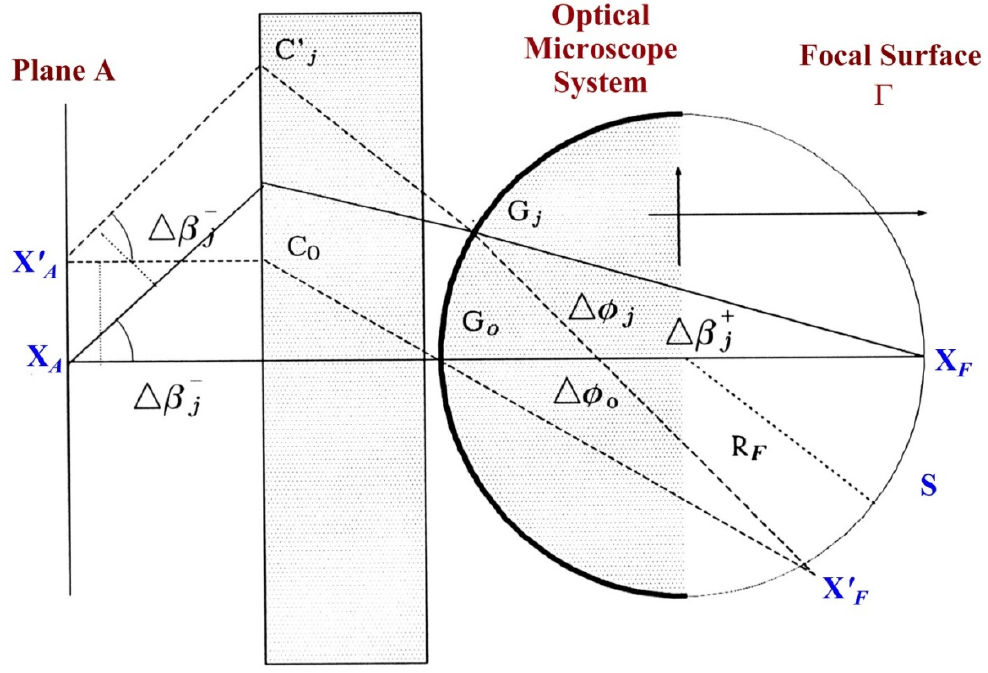
11 Figure 6. The model of a microscope system without spherical aberration. 8.2. Boundary Conditions for a Microscope System without Coma Aberration The boundary conditions for the case when rays emitting from the point X A ’ are gathering together at the point ' F x are more complex.